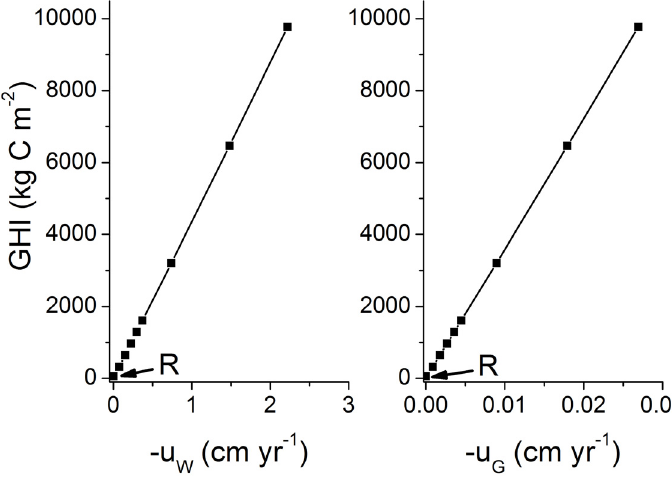
Figure 25. Effect of fluid flow ( u R indicates the reference